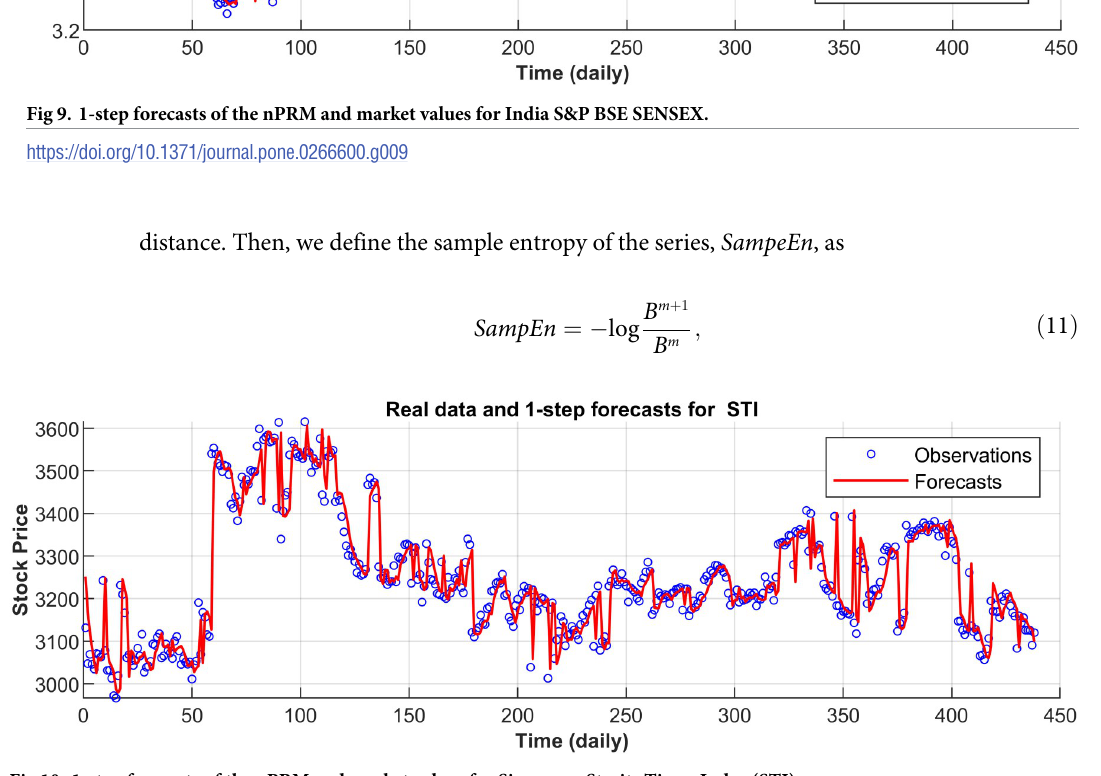
Fig 10. 1-step forecasts of the nPRM and market values for Singapore Straits Times Index